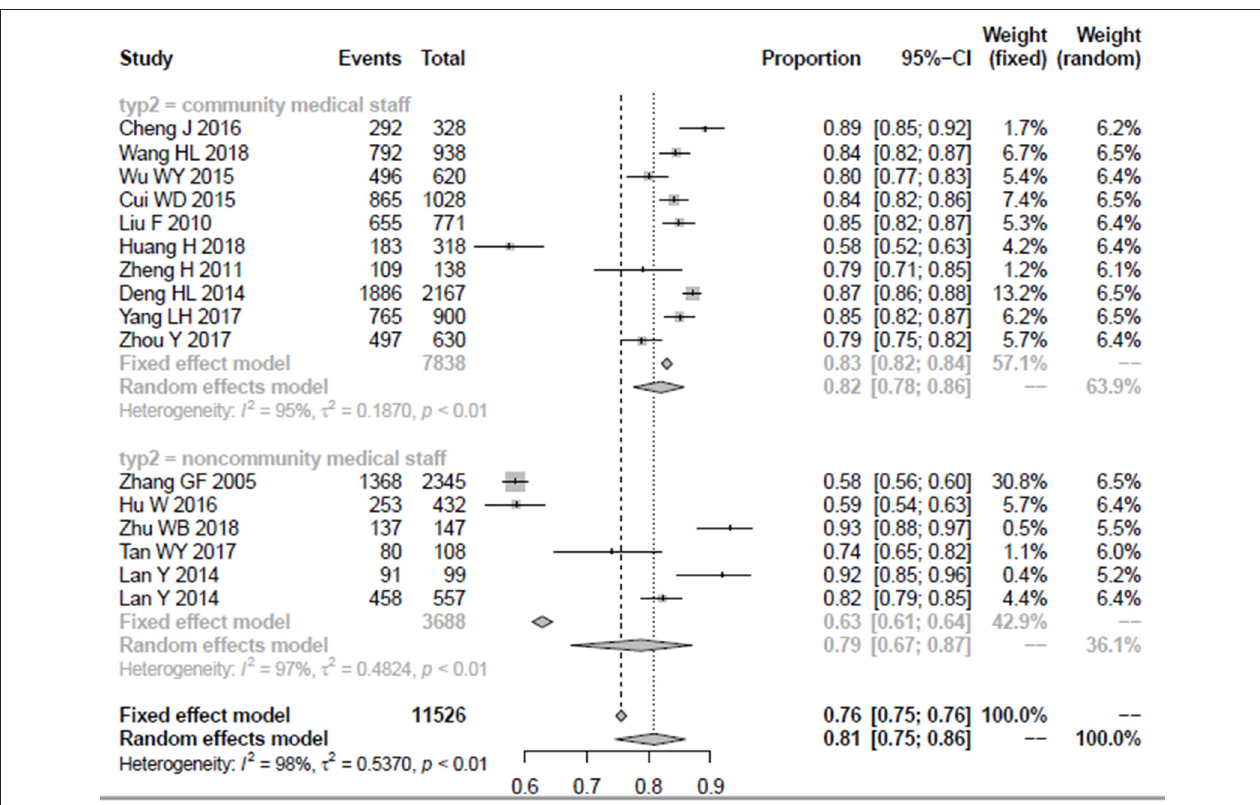
FIGURE 4 | The forest plot of awareness rate among community medical staff and non-community medical staff.